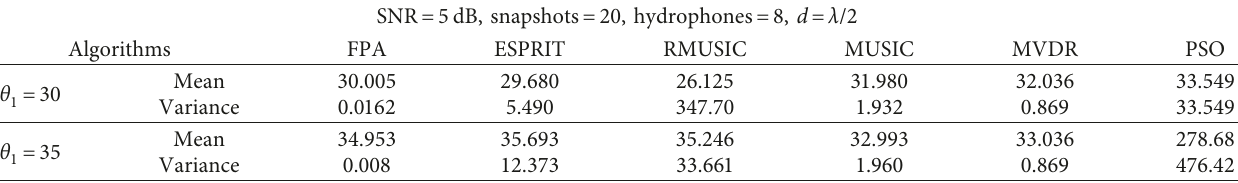
Table 1: Estimation accuracy for two sources.